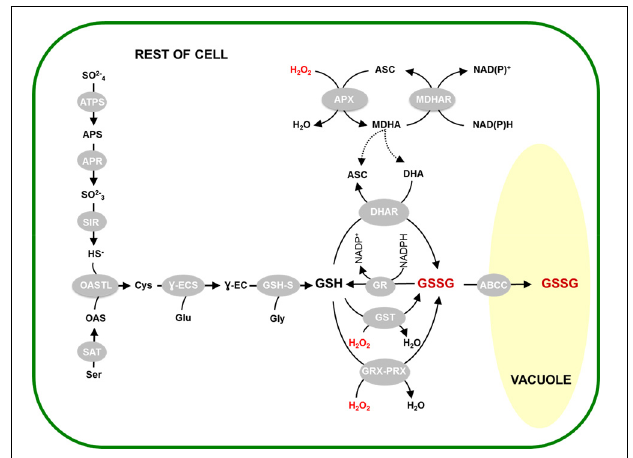
FIGURE 5 | Activation of glutathione synthesis and vacuolar sequestration linked to GSSG accumulation. H 2 O 2 -triggered oxidation of GSH is considered to occur through the activities of DHAR (top), GST (center) or GRX-PRX (bottom). This is accompanied by activation of glutathione synthesis and GSSG sequestration in the vacuole, through the reactions shown on the left and right, respectively. Abbreviations as in Figure 1 legend, or as follows: ATPS, ATP sulphurylase; APS, adenosine phosphosulfate; APR, adenosine phosphosulphate reductase; SIR, sulphite reductase; OAS, O -acetylserine; OASTL, O-acetylserine(thiol)lyase; SAT, serine acetyltransferase; G -ECS, G -glutamylcysteine synthetase; GSH-S, glutathione synthetase; ABCC, sub-class C of the ATP-binding cassette transporters.